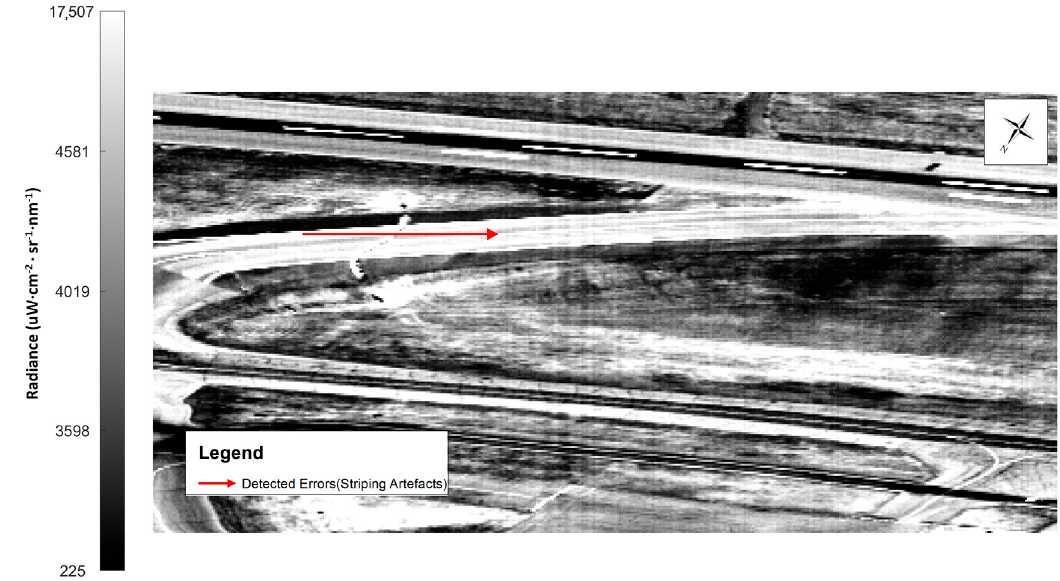
Figure 19. Histogram-equalized CASI imagery (24 June with the original processing) at 706.4 nm. The image is zoomed in to display Columns 57–513 from left to right. There are “striping” artefacts across the FOV. This ripple is clearly visible near the center of the figure, as indicated by the red